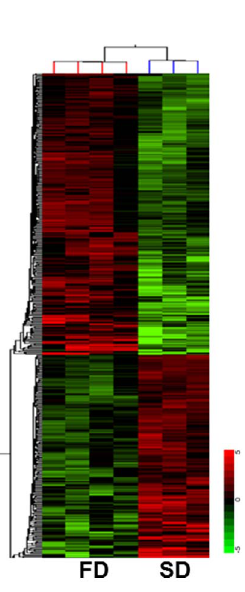
Figure 1. Cluster view (heatmap) of 1,142 genes differentially expressed between the mice fed with fish oil enriched diet (FD) vs. standard lab diet (SD). These genes are identified using a cut-off of 6 1.5 fold changes between the mice with FD vs. SD, with FDR , 0.05, and clustered using Pearson correlation algorithm. The color scale of the fold change (log 1.5 (FD-/SD-fed mice) is noted at the bottom right of the figure. The first three columns from left represent the genomic expressions of 4 animals fed on FD and subsequent three columns of 3 animals fed on SD.